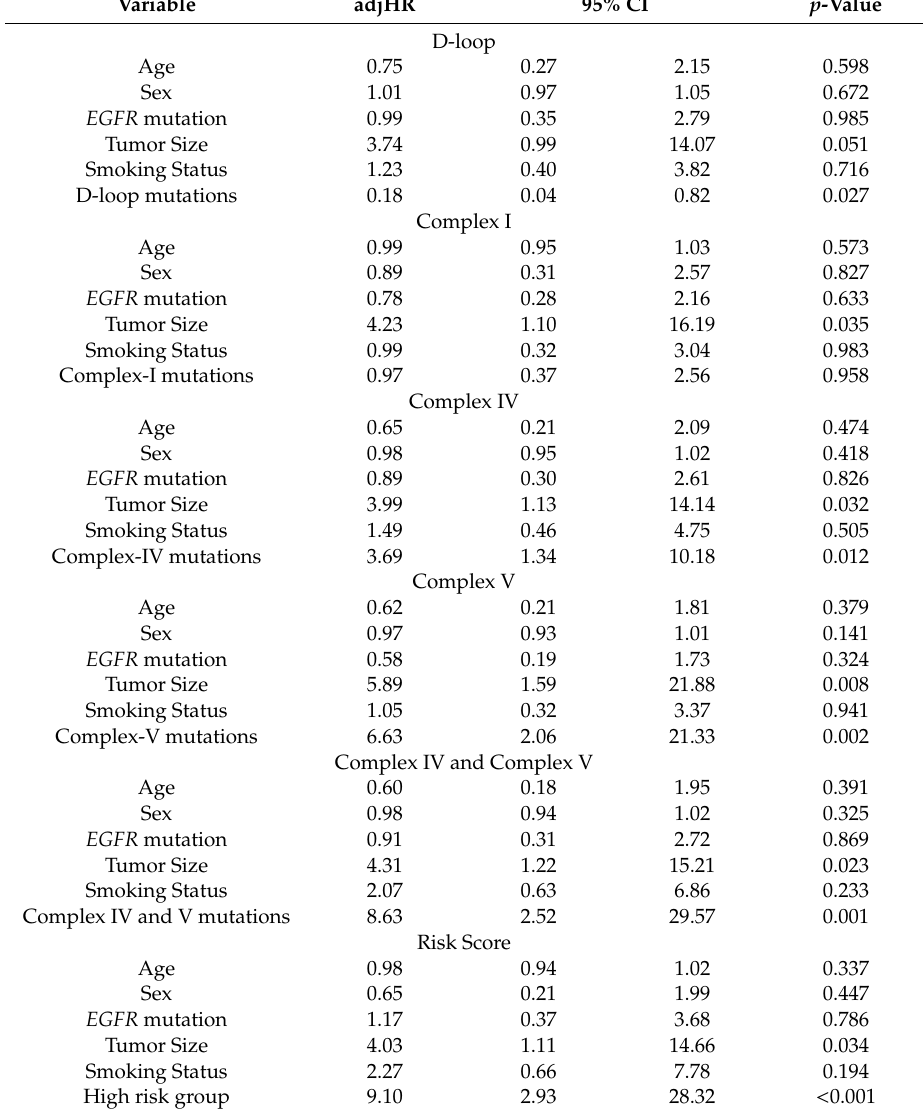
Table 2. Multivariate Cox regression analysis for relapse-free